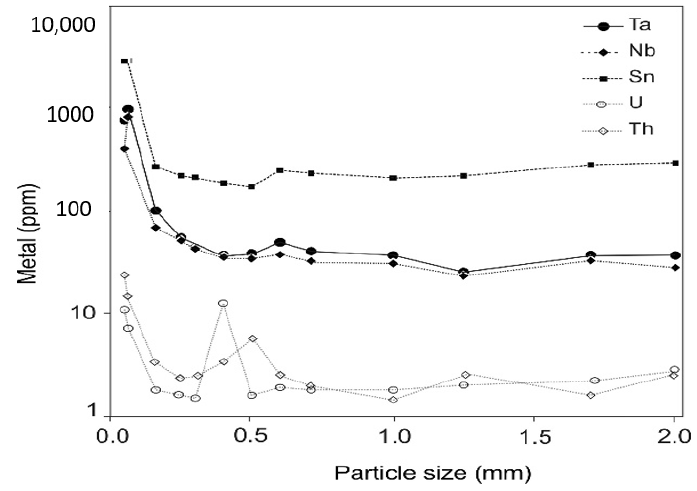
Figure 4. Variations in Ta, Nb, Sn, U, and Th with the particle size of the tailings from Penouta. The chemical composition of the materials used in the ore concentration and the obtained waste Table 2. Chemical composition of the Penouta tailings and the leucogranite outcropping ore including show the e ffi ciency of the concentration process. This was higher in the case of leucogranite outcropping the Nb, Ta, and Sn concentrations and the Nb/Ta ratio used in the experiments in this work. with only 7 ppm of Ta remaining in the final waste. The concentration of Nb did not decrease in the same proportion. In both concentration processes, the wastes contained a quantity of Nb that was even slightly higher than that of Ta (Table 2); however, samples with a greater quantity of Ta than Nb were used. The Nb / Ta ratio varied according to the richness of these oxides: the higher the content of Ta, the lower this ratio will be. This was observed not only for the concentration wastes, but also for the tailing materials and in the original leucogranites (Figure